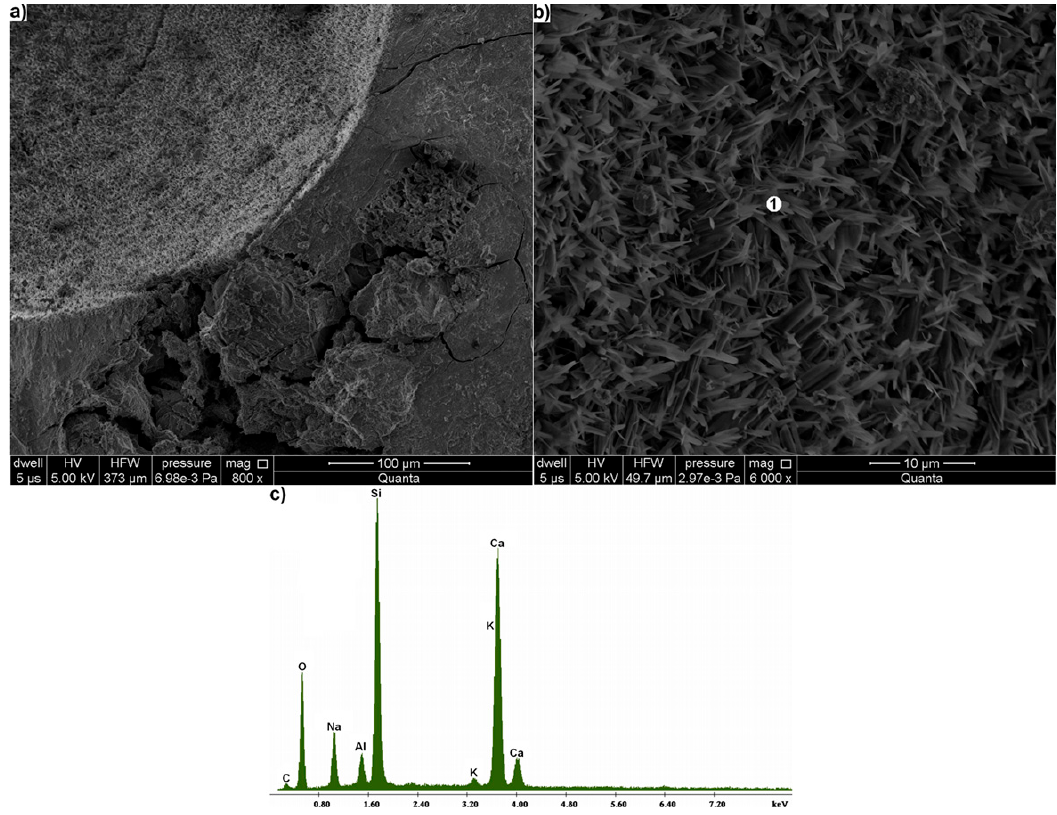
Figure 6. Microstructure of mortar: ( a ) pore in mortar at 800× magnification; ( b ) products of alkali-silica reaction, filling it; ( c ) X-ray microanalysis in point 1.